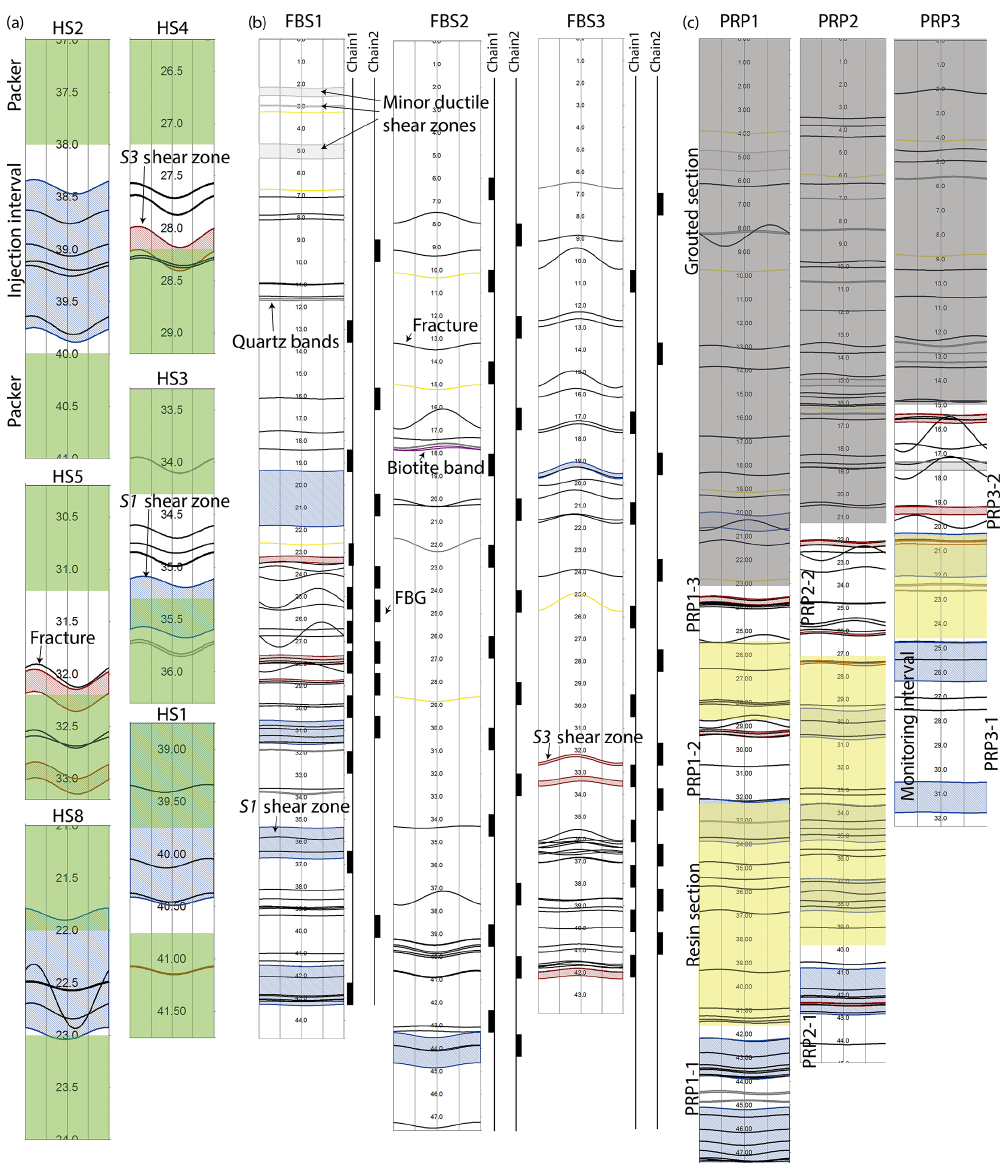
Figure A1. (a) Structure logs of injection intervals, (b) structure logs of strain monitoring boreholes with sensor locations, and (c) customized packer system in the PRP boreholes, including open intervals as well as concrete and resin sections. Note that the actual packers surrounding the open intervals are not shown here due to their length of only